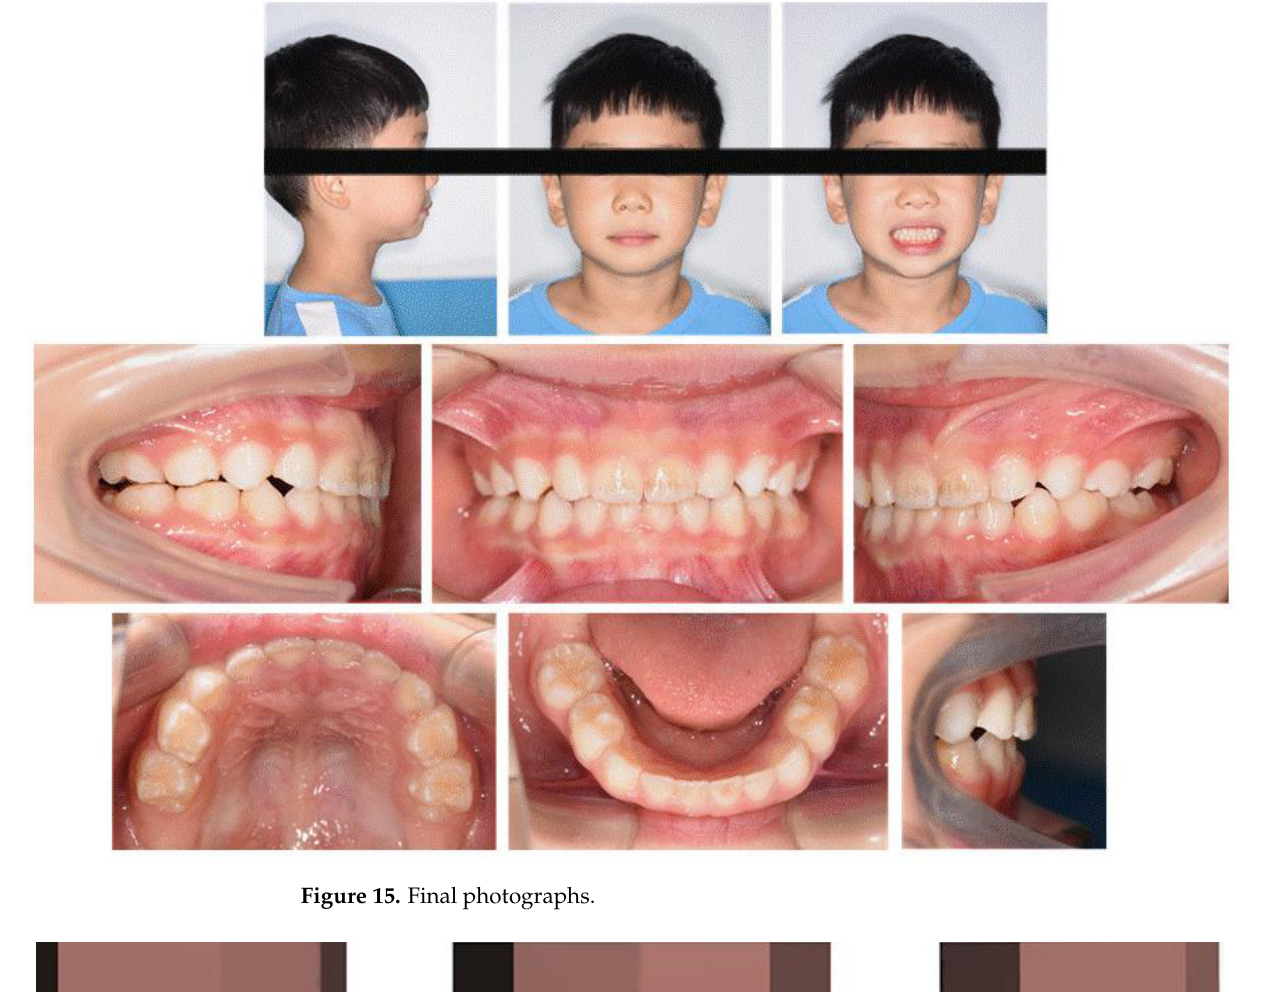
Figure 15. Final photographs.